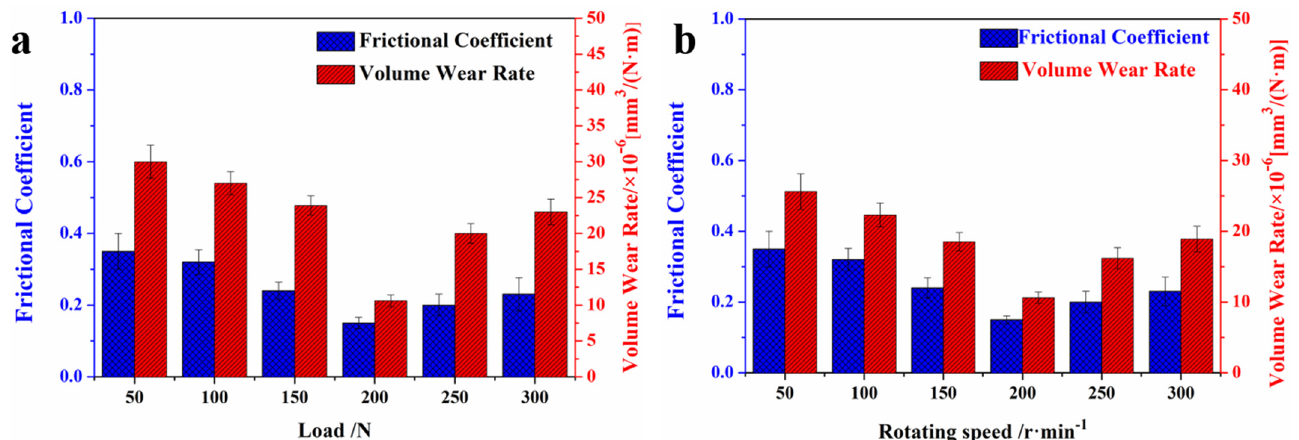
Figure 5. The frictional coefficient and volume wear rate of 0.6 wt% G/COFs/BMI composites with different applied loads ( a ) and rotating speeds ( b ). different applied loads ( a ) and rotating speeds ( b